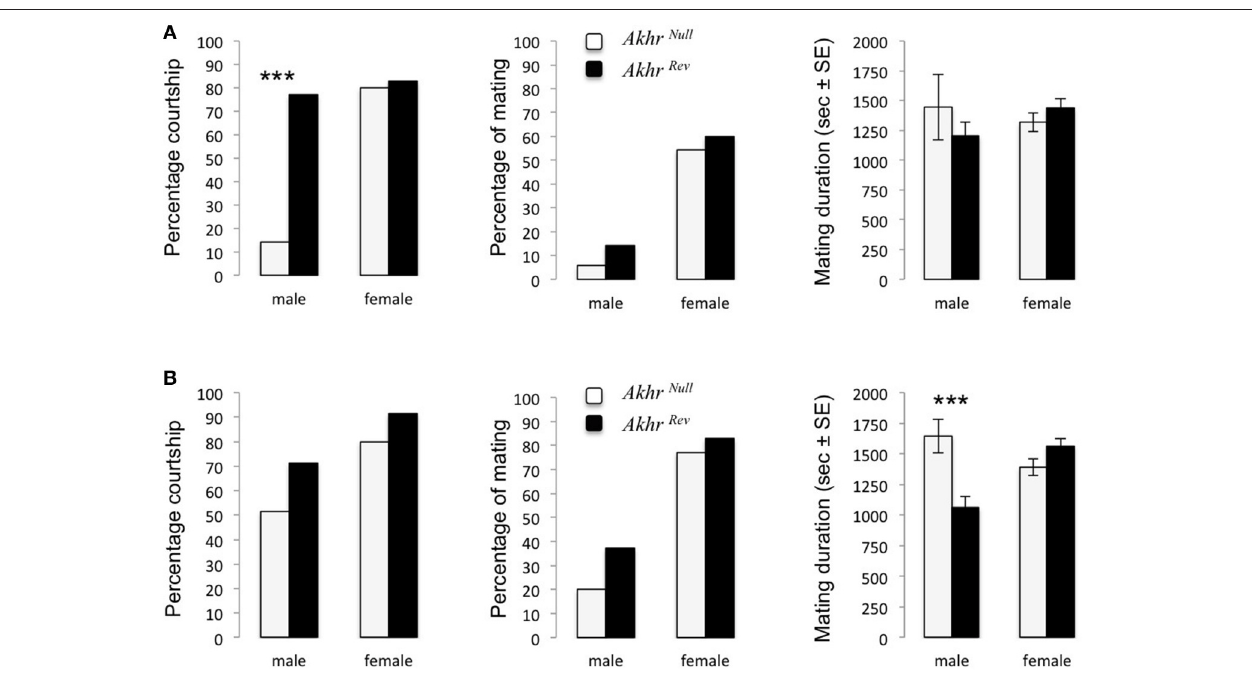
FIGURE 1 | Courtship and mating behavior of AKHR deficient flies. Proportion of couples (an Akhr null or Akhr rev male or female with a wild-type fly of the opposite sex) courting, mating and the corresponding mating duration. Akhr null and Akhr rev flies were either (A) starved or (B) fed. *** p < 0.001 .